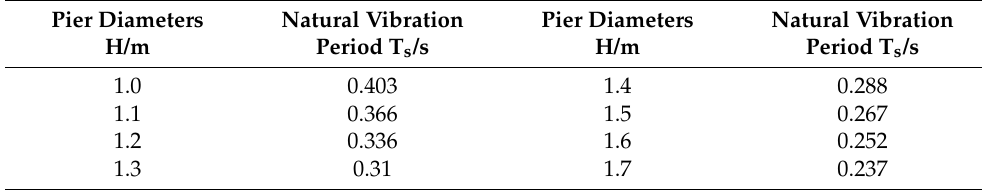
Table 3. Longitudinal natural vibration frequencies of bridges under different